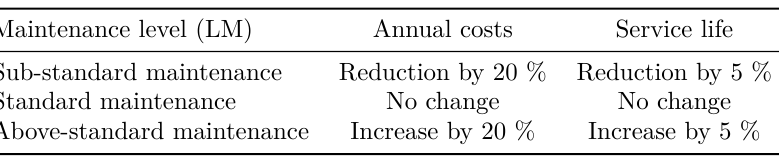
Table 2. Maintenance